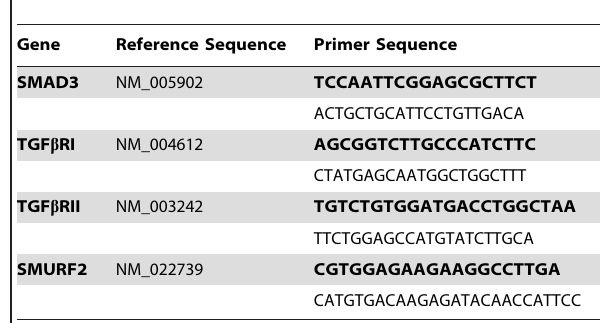
Table 1. Primers for SYBR-green